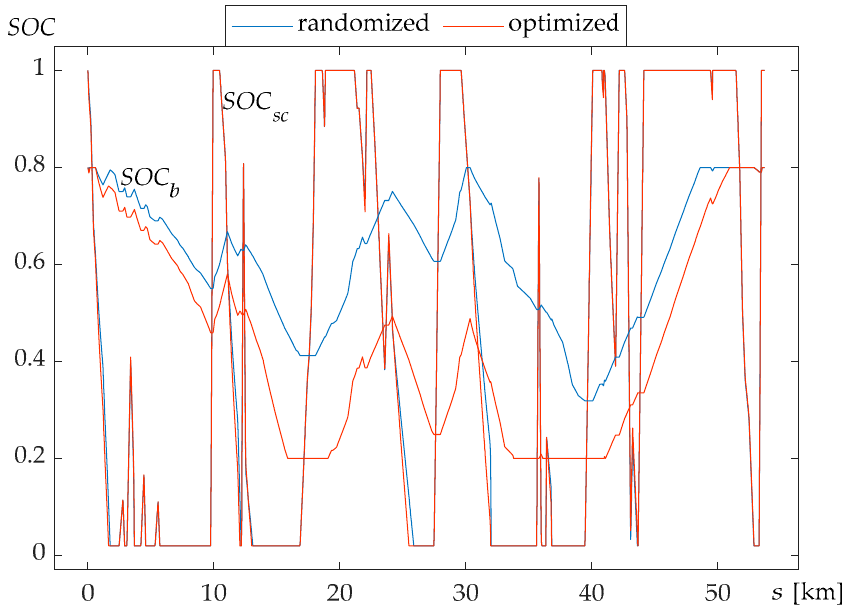
Figure 10. SOC of the battery and the supercapacitor (red is optimized, blue is randomized). Due to the different losses in the devices, according to the hybridization ratios, the total power of all power sources will not always be the same. Consequently, with the optimal hybridization ratio, a lower required total power to propel the train was achieved. By comparing the required train power on the modeled railway for the initial and optimized drive system, this was revealed during acceleration and regenerative braking (Figure 11).